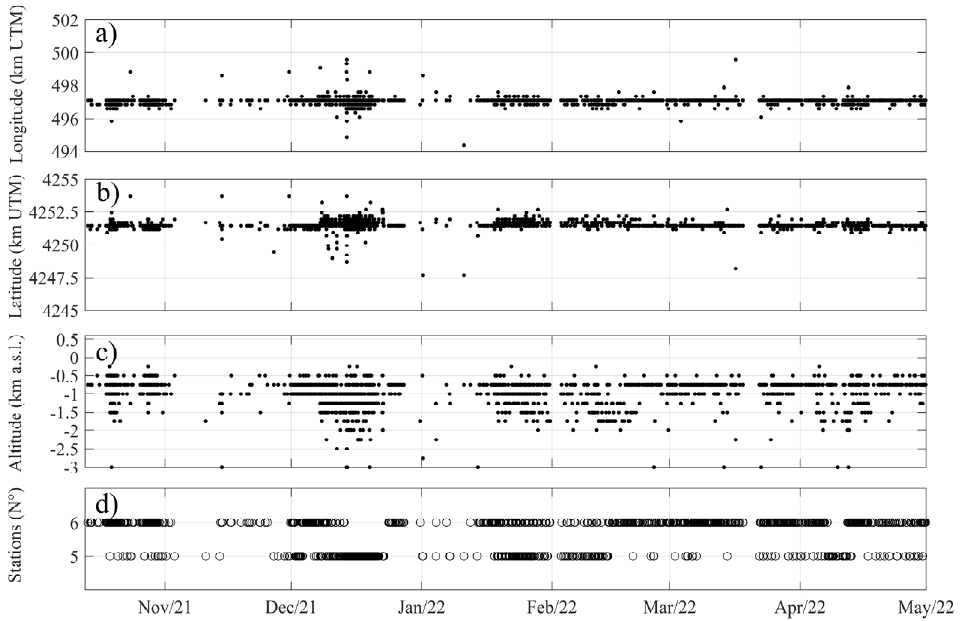
Figure 15. Time series of longitude ( a ), latitude ( b ), and depth ( c ) of VLP seismicity source and ( d ) of the number of stations used in the location.